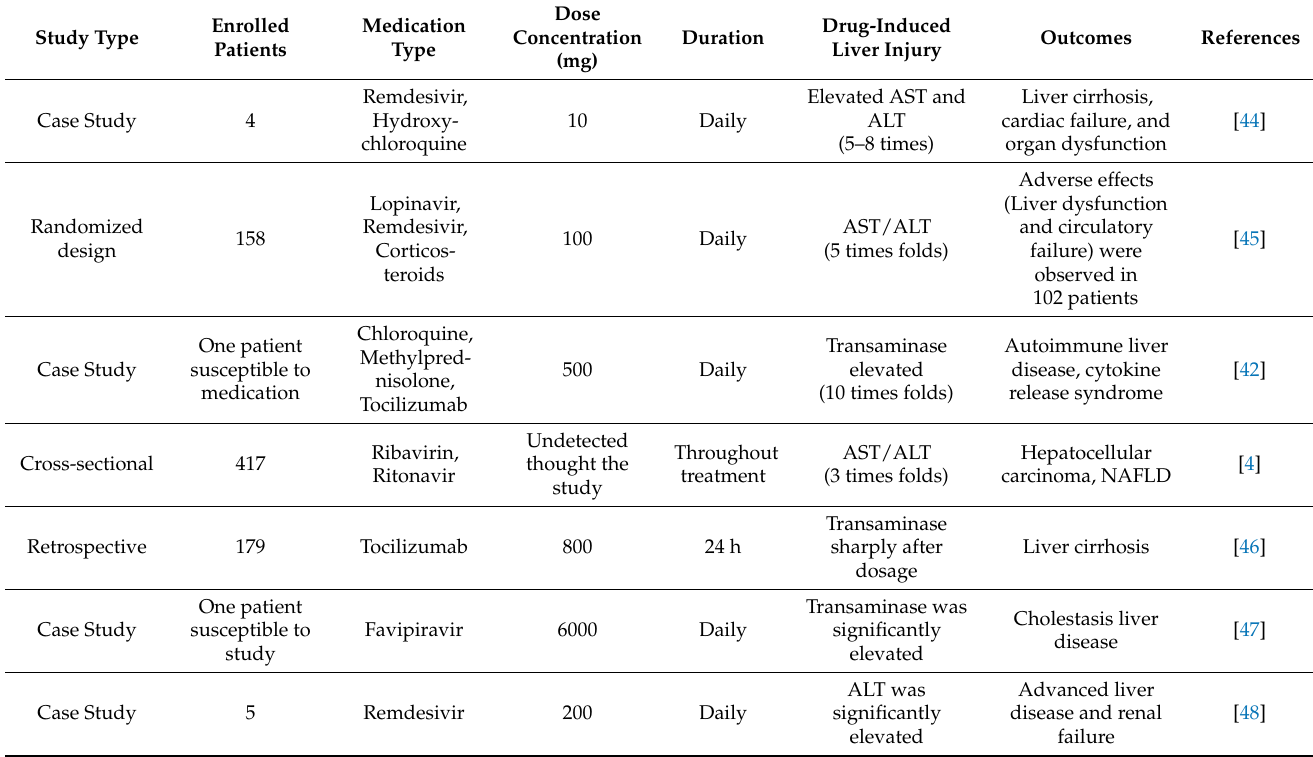
Table 1. The reported studies indicate drug-induced liver injury in COVID-19